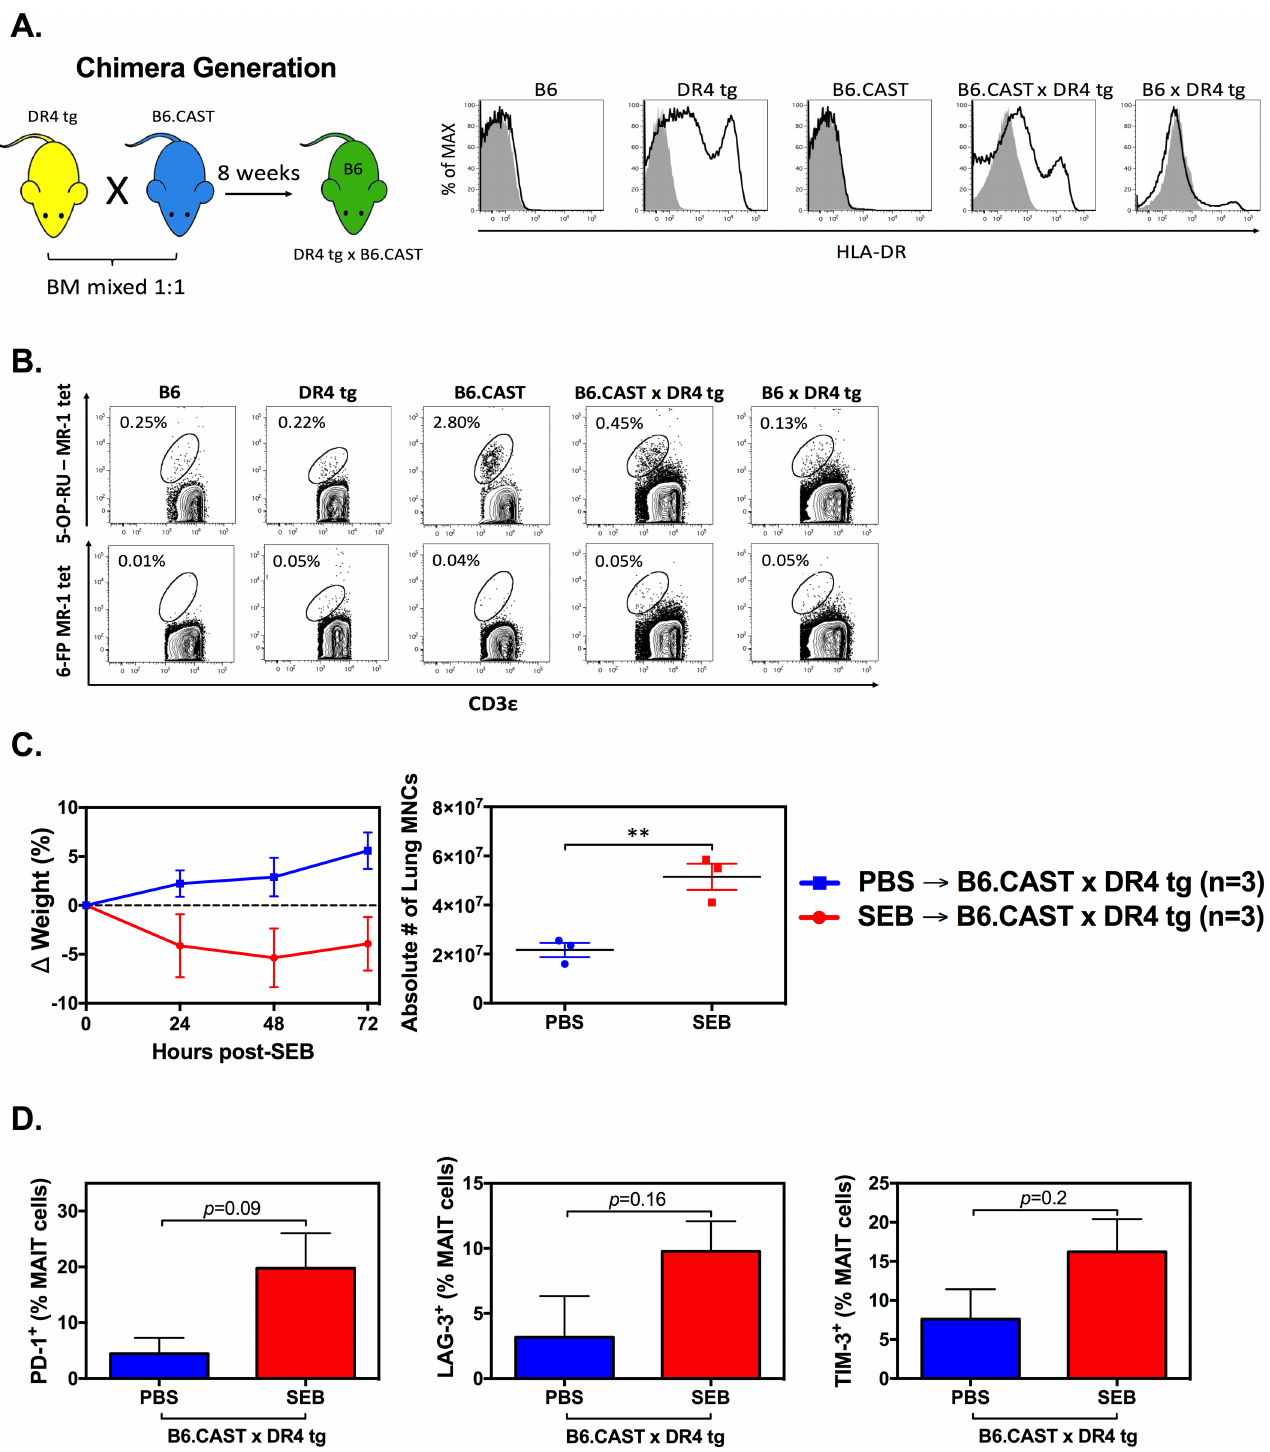
Fig 10. Staphylococcal enterotoxin B (SEB) administration to mucosa-associated invariant T (MAIT) high DR4 + chimeric mice upregulates anergy markerson MAIT cells. Bone marrow cells from DR4-transgenic (DR4 tg) and B6.CAST mice were preparedand co-injected at a 1:1 ratio into γ -irradiatedB6 mice. Controlchimeras were generatedby co-transferring B6 and DR4 tg marrow cells into B6 recipients. The expressionof HLA-DR, or lack thereof, was assessedby flow cytometry in the above chimeras as well as in wild-typeB6, DR4 tg, and B6.CAST mice. Filled histograms correspondto background stainingwith a mouse IgG2a isotype control ( A ). In addition,lung MAIT (CD3 + 5-OP-RU-MR1 tetramer + )